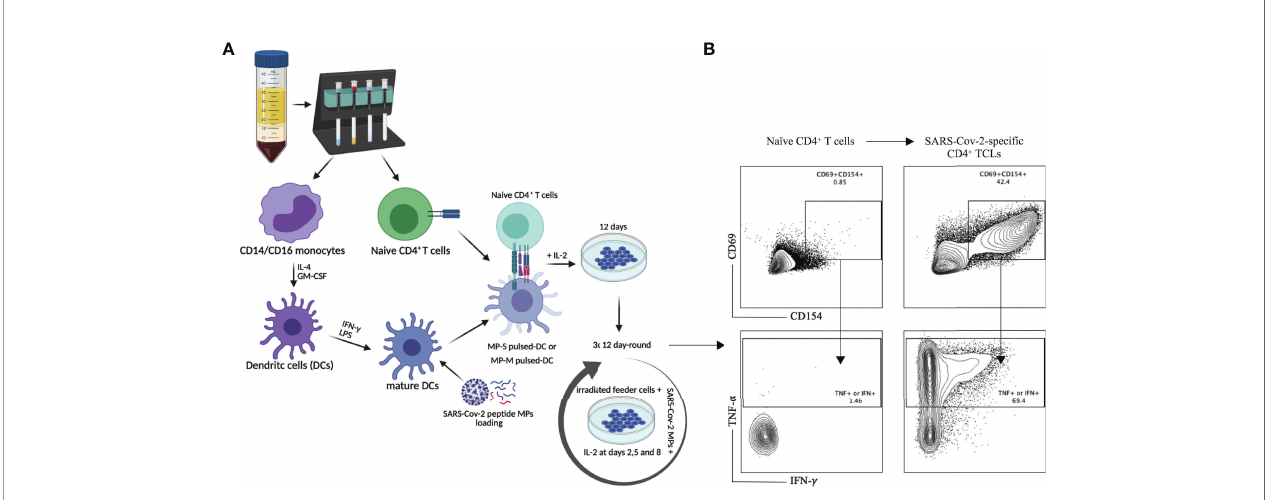
FIGURE 1 | SARS-Cov-2 antigen-speci fi c CD4 + T-cell line generation from healthy donor PBMC. Panel (A) demonstrates the methodology used for generation of the various TCLs beginning with healthy donor naive T-cells and driven by SARS-Cov-2 structural spike (S) and membrane (M) protein-based peptide megapools. Panel (B) shows a representative fl ow cytometric dot plot highlighting the immunophenotypic conversion from naïve T cells to SARS-CoV-2-reactive CD4 + TCLs expressing CD69 + CD154 + and producing either IFN- g or TNF- a upon stimulation with SARS-CoV-2 peptide pools. Figure 1A was created with